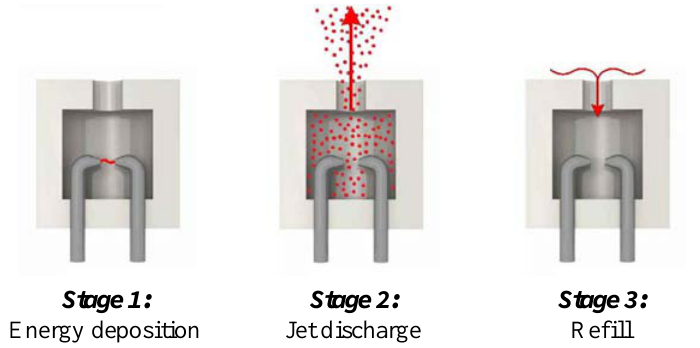
Figure 2. Different phases in one working cycle of plasma synthetic jet